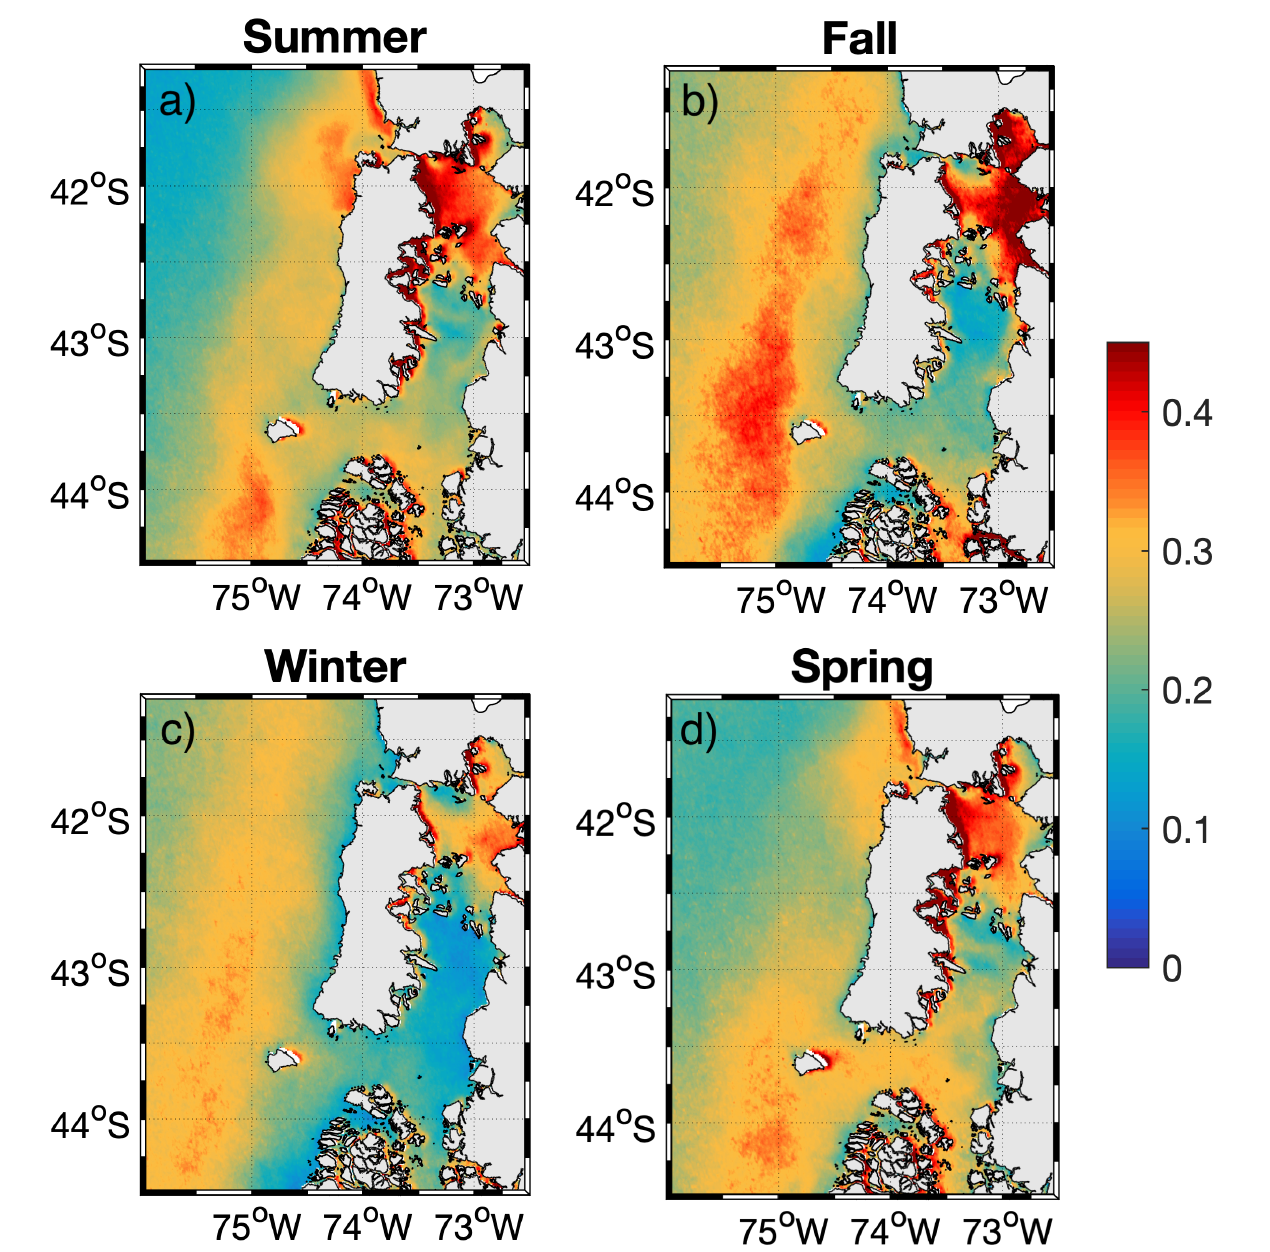
Figure 6. Seasonal climatology (2003–2019) of chlorophyll fluorescence (nFLH; W m − 2 µ m − 1 sr − 1 ) in the Inner Sea of Chiloé and its adjacent coastal ocean for ( a ) summer (January, February, March), ( b ) fall (April, May, June), ( c ) winter (July, August, September), and ( d ) spring (October, November, December). For reference of locations see Figure